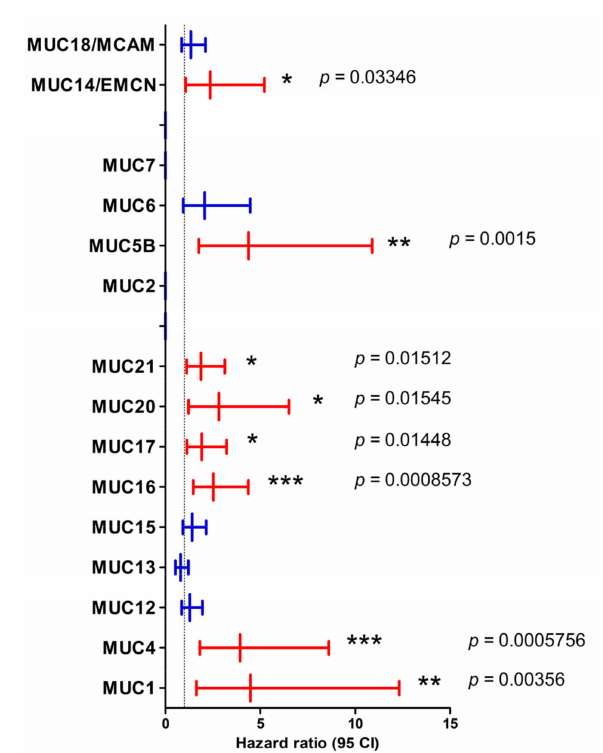
Figure 2. Hazard ratio in high and low expression levels of mucin genes in pancreatic adenocarcinoma (PAAD) cohort. Hazard ratio (HR) was calculated in population designated as high risk and low risk (higher value of mucin gene of interest for higher risk) on the basis of individual mucin expression by the SurvExpress optimized algorithm in PAAD from TCGA datasets. Statistically significant hazard ratios ( p < 0.05) are represented in red. The p -value is indicated on the graph (***, p < 0.001; **, p < 0.01; *, p <